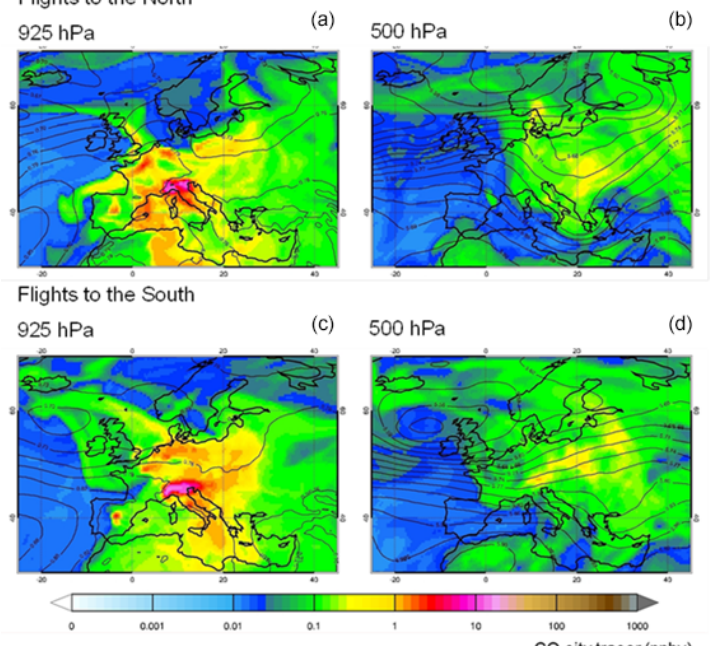
Figure 8. Coloured shadings of composite averages of CAMS global city tracer forecasts of CO (ppbv) at 925hPa ( a, c ) and 500hPa ( b, d ) and 12:00UTC for days of flights to the north (E-EU-05, E-EU-08, a–b ) and south (E-EU-03, E-EU-06, E-EU-07, E-EU-09, c–d ) of Europe. Black contours show corresponding averages of geopotential height (km) from the ECMWF Integrated Forecasting System